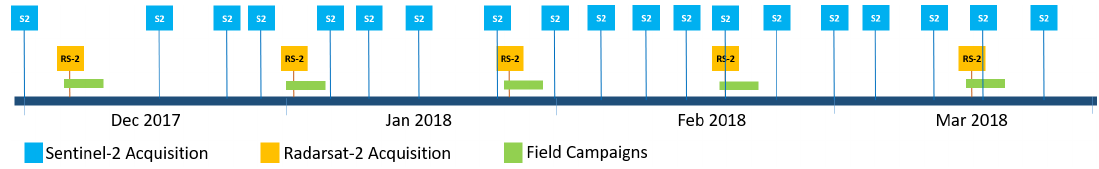
time series of RADARSAT-2 and Sentinel-2 data for